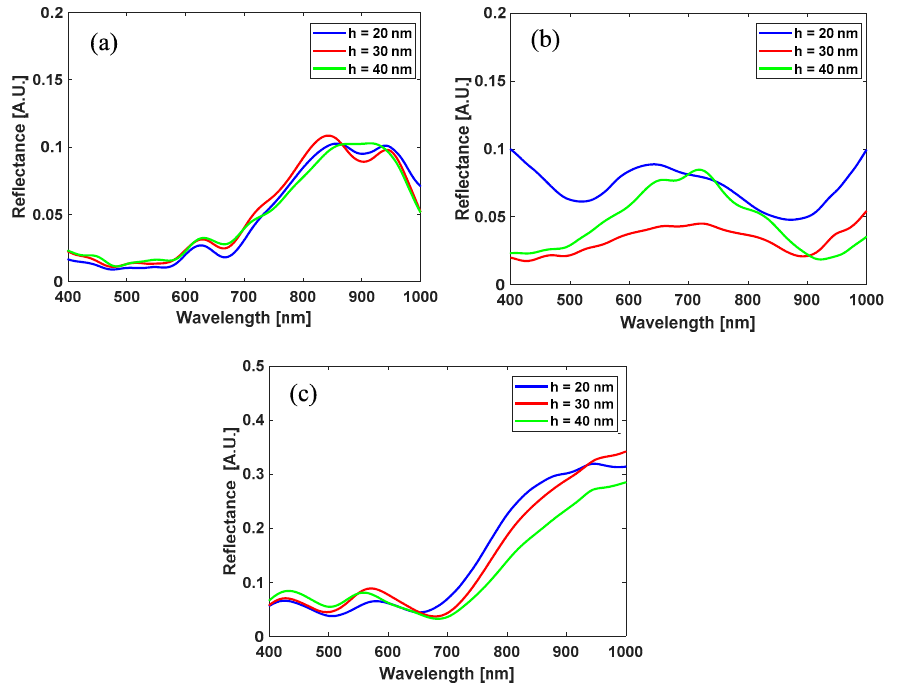
Figure 3. Reflectance spectra measured on CPA substrates with different diameters ( d = 500 nm ( a ), 750 nm ( b ), 1000 nm ( c )) and different gold films ( h = 20 nm, 30 nm, 40 nm).